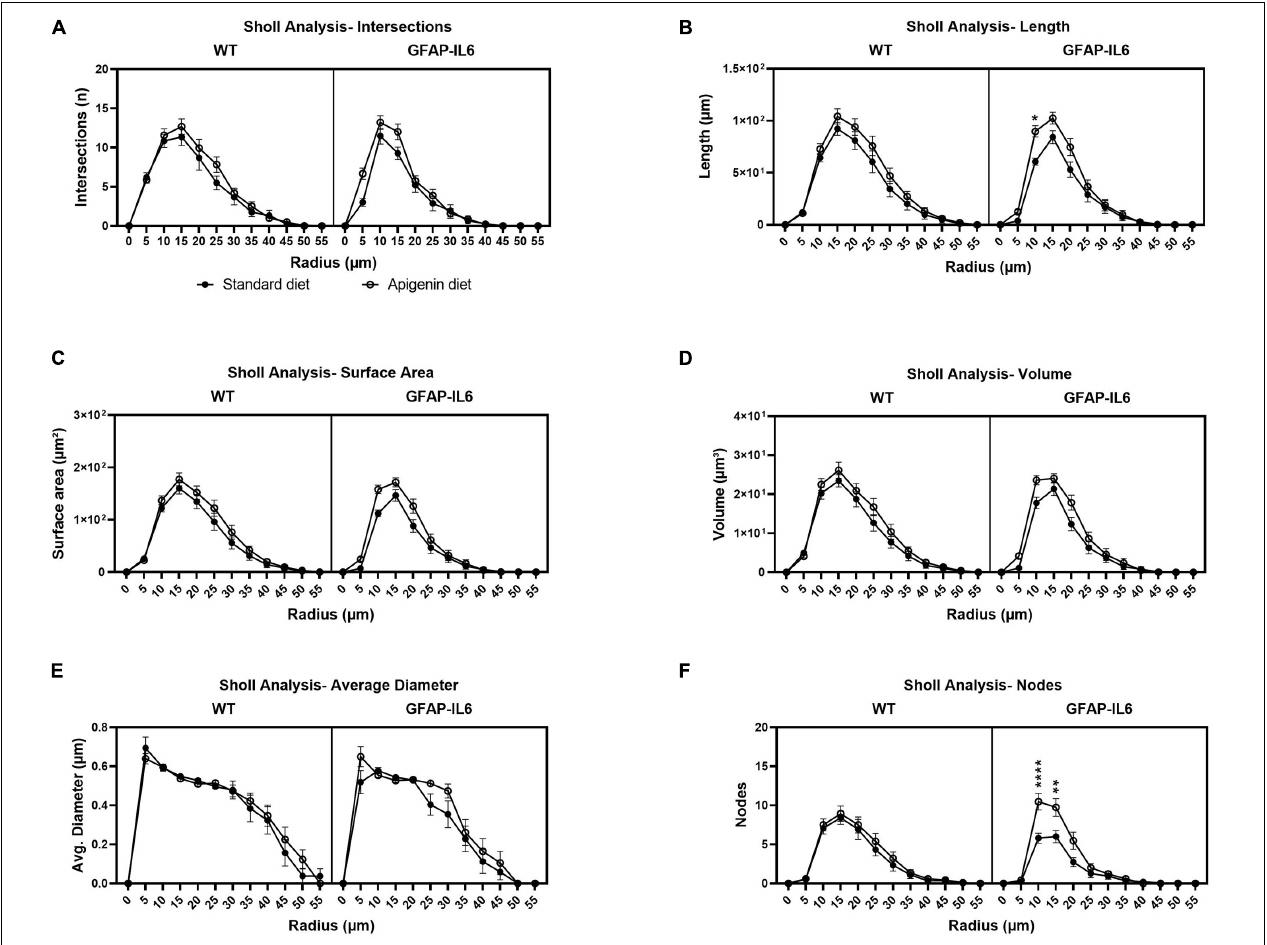
FIGURE 6 | Sholl analysis used to quantify microglia arborization complexity between WT and GFAP-IL6 mice fed control and apigenin diets. Microglial arborization complexity is presented via microglial intersections (A) , length (B) , surface area (C) , volume (D) , average diameter (E) , and nodes (F) . In (B) a significant increase in process length was detected at a radius 10 µ m from the soma for GFAP-IL6 apigenin-fed mice compared to GFAP-IL6 standard diet-fed mice. In (F) there was a significant increase in number of nodes detected at radius 10 and 15 µ m for GFAP-IL6- apigenin-fed mice compared to GFAP-IL6 standard diet-fed mice. Data were analyzed using three-way ANOVA and presented as mean ± SEM. Bonferroni’s multiple comparison “diet” effect represented by asterisks (* p < 0.05, ** p < 0.01, *** p < 0.001, **** p <